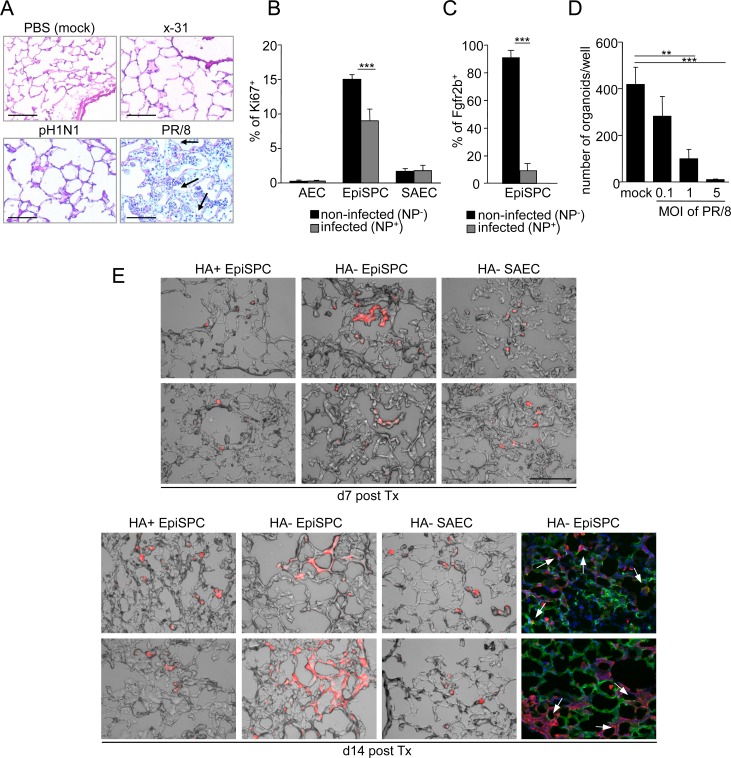
Influenza virus infected EpiSPC are impaired in their regenerative response due to restricted Fgfr2b expression.(A) Wt mice were infected with 500pfu of the indicated influenza virus strains, or mock-infected, and lung sections were stained with hematoxylin-eosin at d21 pi (arrows indicate areas of non-epithelialized tissue). (B) Infected and non-infected epithelial cell subsets of PR/8 infected wt mice were quantified by flow cytometry for their proliferative response. (C) Quantification of Fgfr2b expression in infected (NP+) and non-infected (NP-) EpiSPC by flow cytometry at d4 pi. (D) Flow-sorted EpiSPC were ex vivo infected with the indicated MOI of PR/8 and seeded in matrix for 3D cultures. At d6 of culture, the number of formed organoids was quantified. (E) Infected (hemagglutinin+; HA+) or non-infected (hemagglutininneg; HA-) EpiSPC or control HA- SAEC were flow-sorted from the lungs of PR/8-infected tdtomato+ mice at d4 pi for intrapulmonary transplantation into 7d PR/8-infected wt mice. Lung sections were obtained at d7 and d14 after transplantation. Representative micrographs show overlays of brightfield and red staining of tdtomato+ transplanted cells. Overlay of tdtomato+ transplanted cells (red) and the type I AEC cell marker T1α (green) is shown in the right panels (arrows indicate co-expression of T1α and tdtomato); bars = 100μm. Bar graphs represent means ± SD of n = 3–4 independent experiments; * p<0.05; **p<0.01; ***p<0.001; HA, hemagglutinin; Tx, transplantaion.